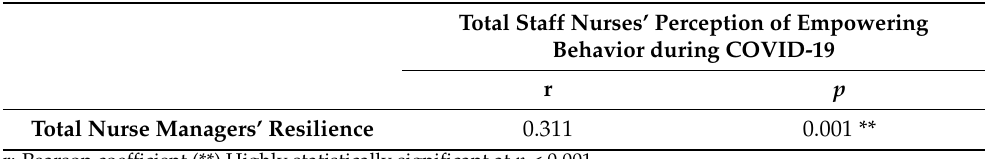
Table 6. Pearson’s correlation coefficient between total nurse manager’s resilience skills levels and total staff nurses’ perception of empowering behavior during COVID-19.